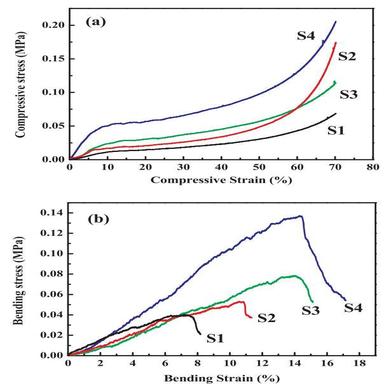
The compressive (a) and bending (b) stress-strain curves of PFMs at different compressive percentages.